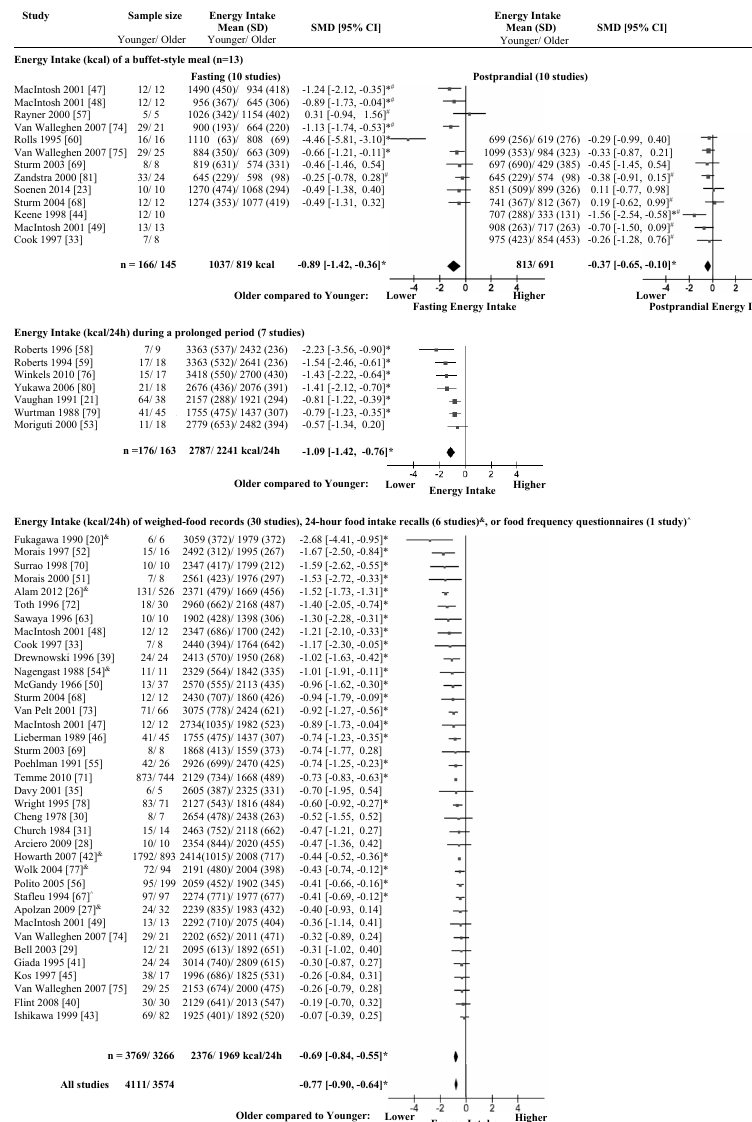
Figure 2. Energy intake. Mean ˘ SD of energy intake (kcal) and a plot of the standardized mean difference (SMD; mm) of energy intake in older compared with younger subjects with the DerSimonian and Laird random-effect model. The horizontal lines denote the 95% confidence interval; (cid:4) point estimates (the size of the square corresponds to its weight); (cid:7) the pooled estimate of age effect. Three different methods of measuring energy intake were distinguished: (i) energy intake of a single ad libitum buffet-style meal at the research facility after overnight fasting and in a postprandial state after a nutrient preload, administered orally or infused directly into the small intestine; (ii) energy intake of provided food items during a prolonged period; and (iii) energy intake of weighed food records, 24-h food intake recalls, or food frequency questionnaires. In the total group of 7685 subjects, energy intake was less (SMD: ´ 0.77 (95% CI ´ 0.90 to ´ 0.64), I 2 = 76%, p < 0.001) in the older than the younger adults. * p < 0.05 energy intake significantly less in older than younger adults within the study; # data were derived from a figure of the original publication; food records, & 24-h food intake recalls; or ˆ food frequency